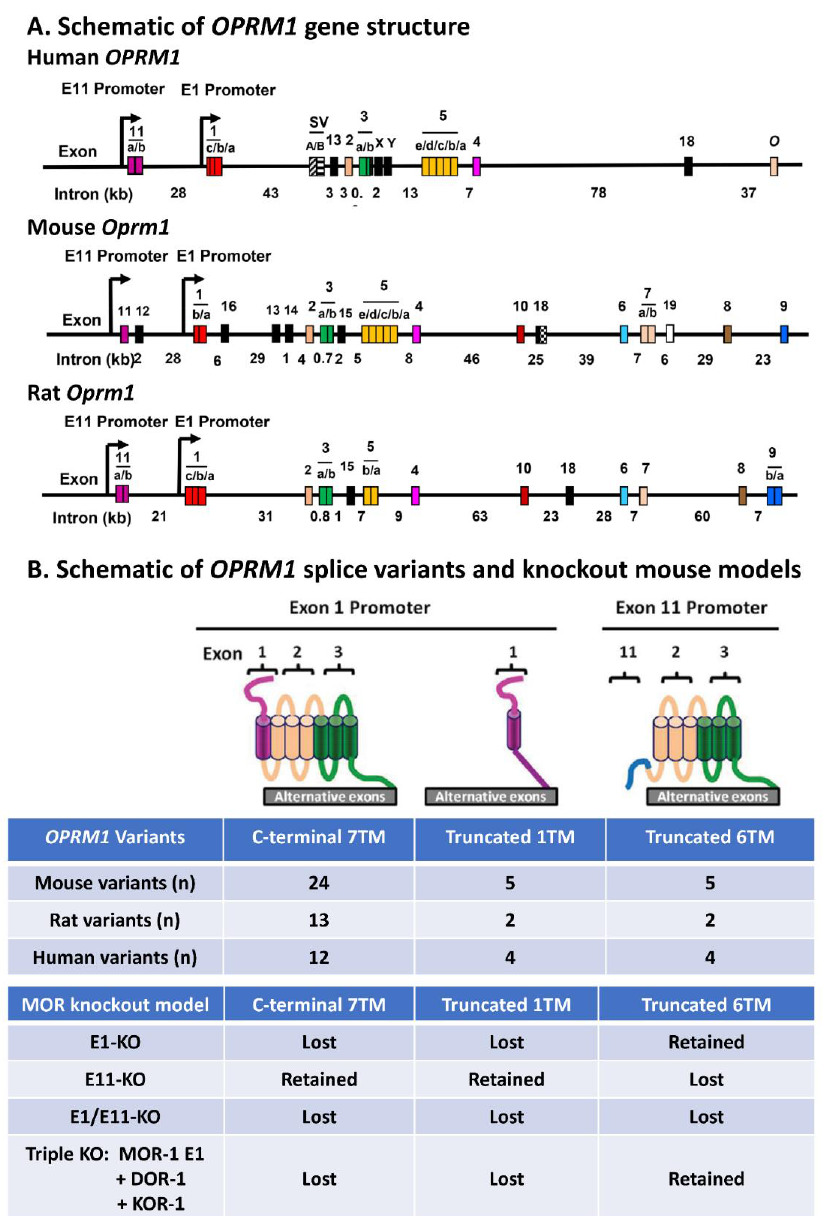
Figure 1. Schematic of the OPRM1 gene structures, splice variants, and related knockout (KO) mouse models. ( A ) The schematic of the human, mouse, and rat OPRM1 gene structures adapted from [9]. Exons and introns are shown by colored boxes and horizontal lines, respectively. Promoters are indicated by arrows. Intron sizes are indicated as kilobases (kb). Exons were numbered based on the published data, not by their genomic location, to keep consistent with the literature. The sequence IDs of the human, mouse, and rat OPRM1 genes in Ensembl are ENSG00000112038, ENSMUSG00000000766, and ENSRNOG00000018191, respectively. Note: the exons in Ensembl or other genome browsers were numbered based on their genomic locations. The exon and intron distances are not drawn to scale. The exon composition of OPRM1 splice variants and the role of these splice variants were described in previous reviews [8,9,11,12]. ( B ) Schematic of the OPRM1 splice variants and KO mouse models adapted from [48]. Top panel: Three types of receptor structures, full-length 7TM C-terminal and truncated 1TM and 6TM, that were predicted from their transmembrane do- mains (TMs). Lower panel of the tables: The upper table indicates the number of each type of the splice variants in the mouse, rat, and human OPRM1 genes. The bottom table shows four KO mouse models targeting these three types of